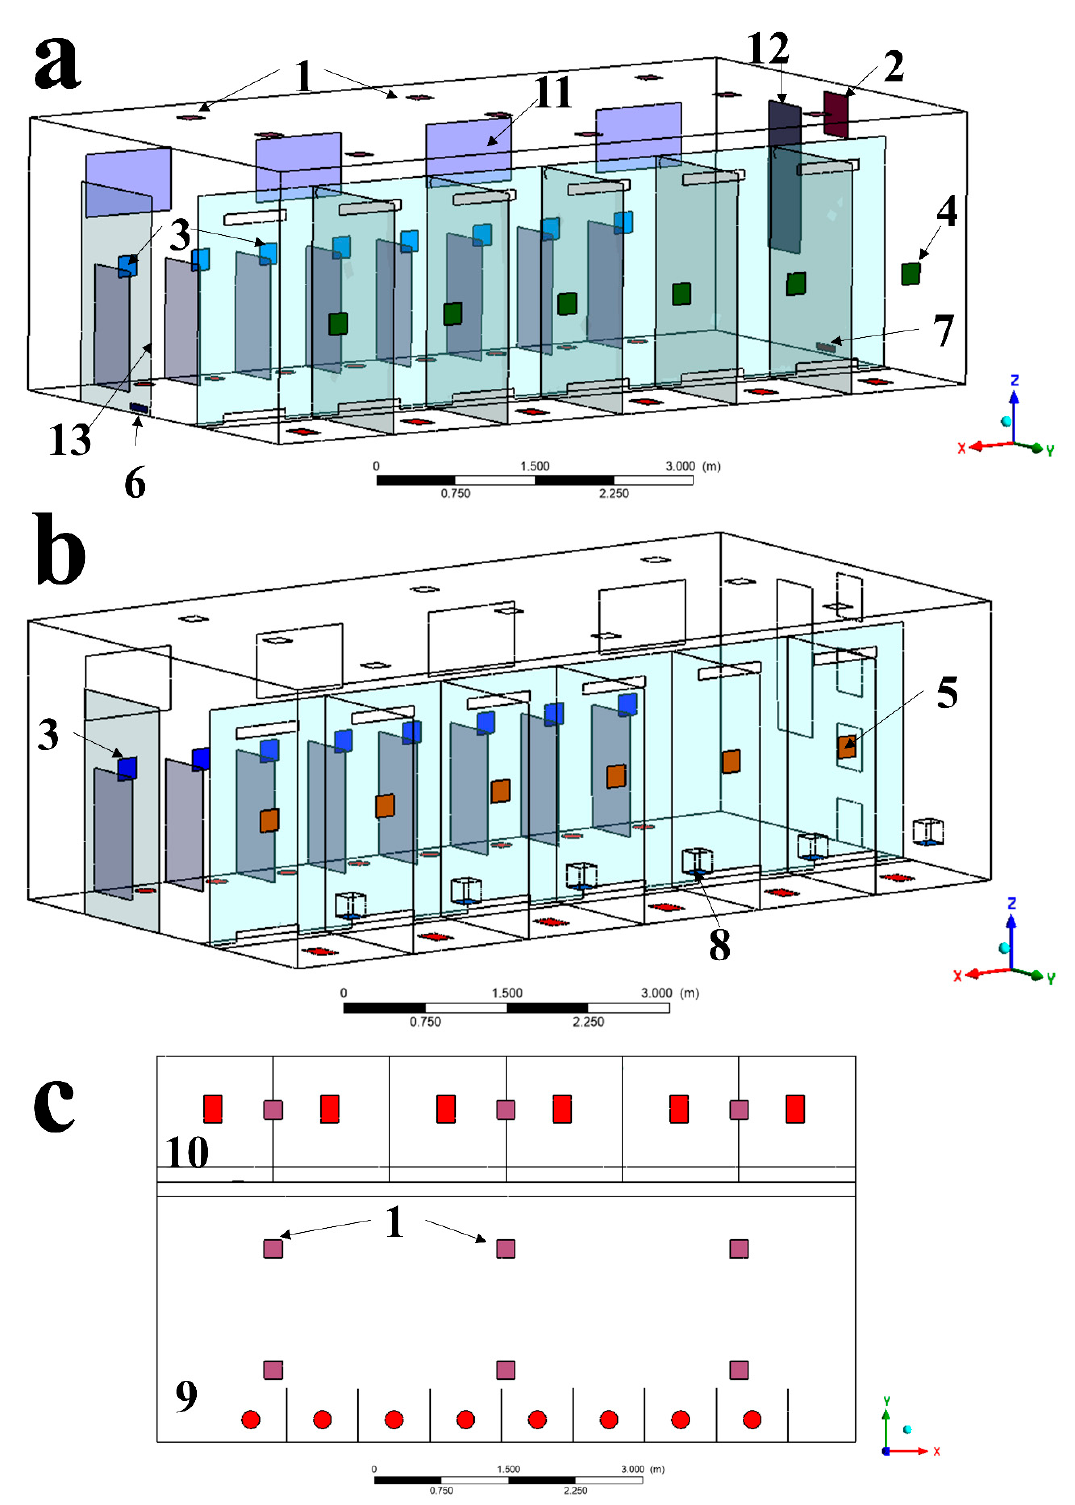
Figure 1. Geometry of the public toilet model: ( a ) vent positions in MV, PV, and IJV; ( b ) vent positions in IJV; ( c ) top view. 1—M 1 ; 2—M 2 ; 3—PV-U 1 ; 4—PV-S 1 ; 5—PV-S 3 ; 6—J 6 , 7—J 7 ; 8—J 1 ; 9—Urinal; 10—Stall; 11—Window; 12—Window; 13—Door. M 1 , S 2 , S 3 , and M 2 are outlet; J 1 , J 2 , J 3 , J 6 , J 7 , and S 1 are inlet.